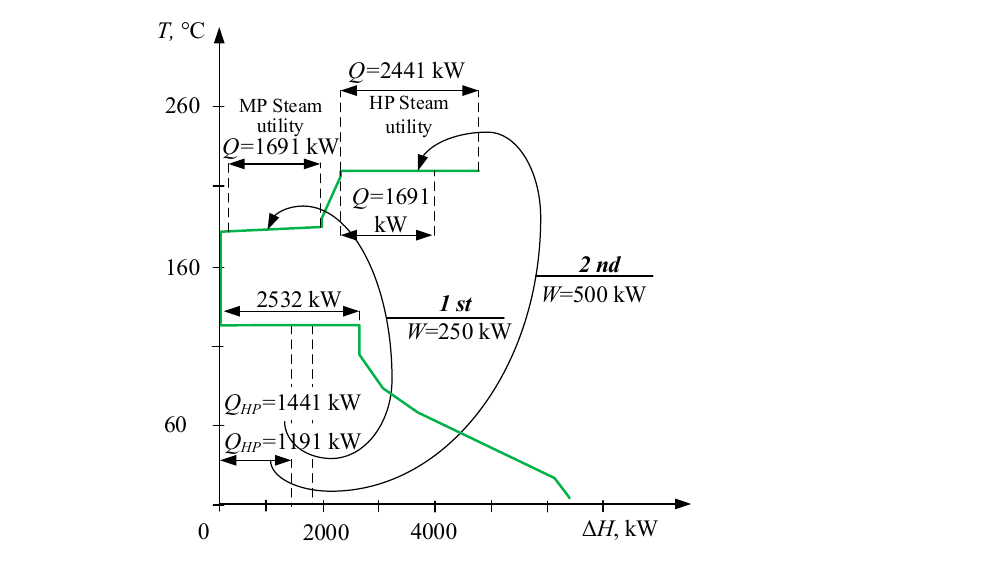
Figure 7. GCC of the EB production process. Q HP —heat output transported by the HP , W —is the power on the shaft of the HP compressor.